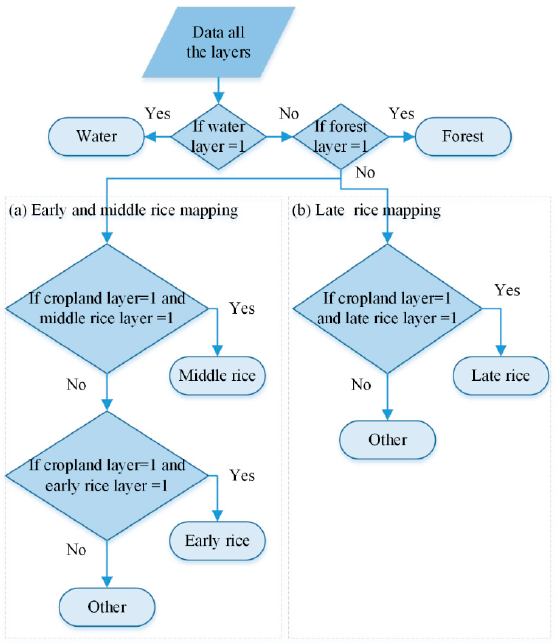
Figure 7. Process used for the comprehensive mapping of paddy rice extent. “Water layer = 1” indicates that the attribute of the pixel was water on the water layer, or the pixel attribute was non-water. The other pseudocode (e.g., “forest layer = 1”, “cropland = 1”) in Figure 7 has the same meaning.